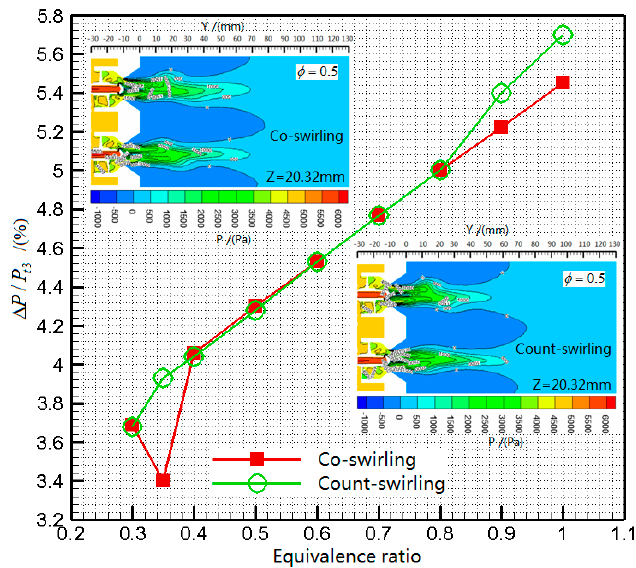
Figure 7. Total pressure drop coefficient profiles and contours compared between co-swirling and count-swirling four-point LDI combustors with different equivalence ratios.